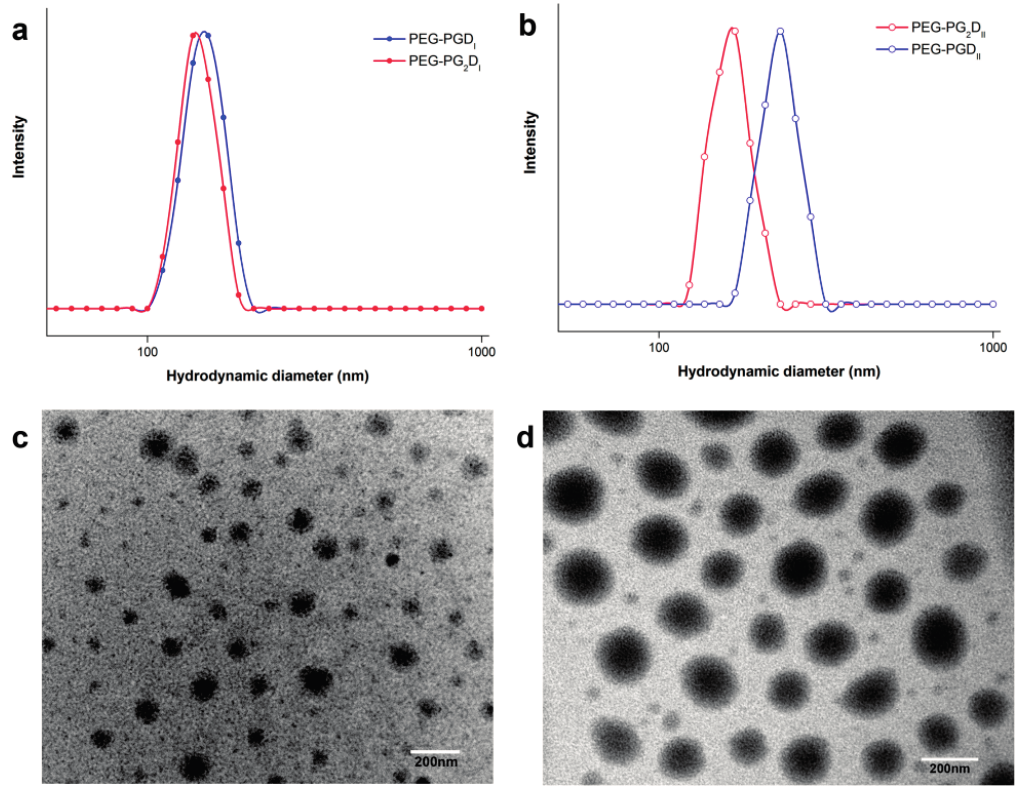
D micelles ( a ) or ( b ), 2